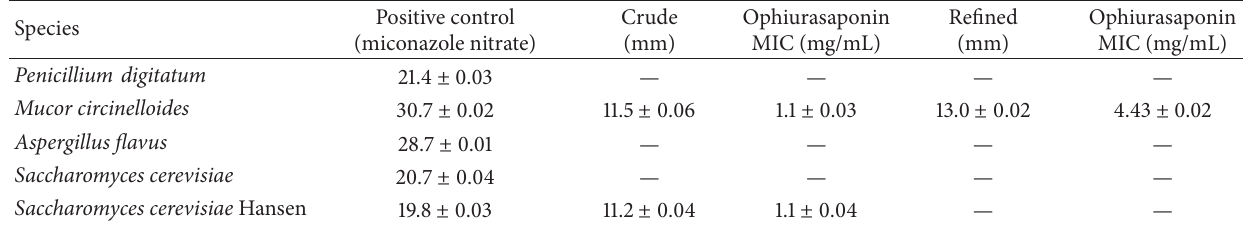
Table 3: Inhibition of ophiurasaponin from Ophiopholis mirabilis on fungi 𝑛 = 3